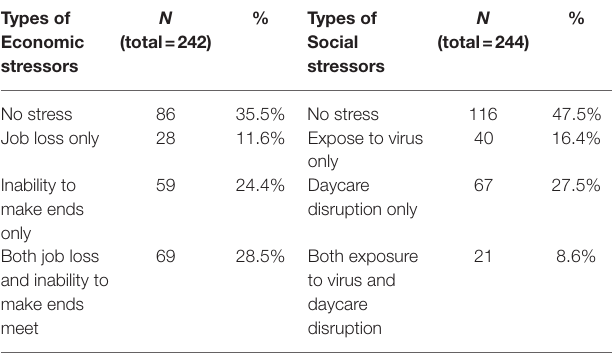
TABLE 2 | Number and Percent of Parents Encountering the COVID19-related